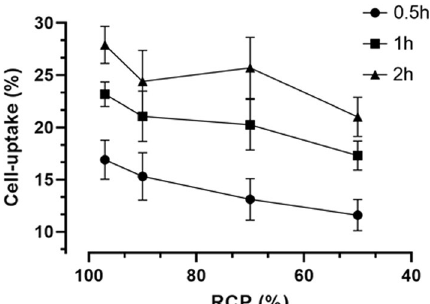
Fig. 4 Correlation between the RCP (%, x-axis) and cell-uptake (%, y-axis), showing that a decrease in RCP leads to a decrease in cell-uptake ( n 3 =